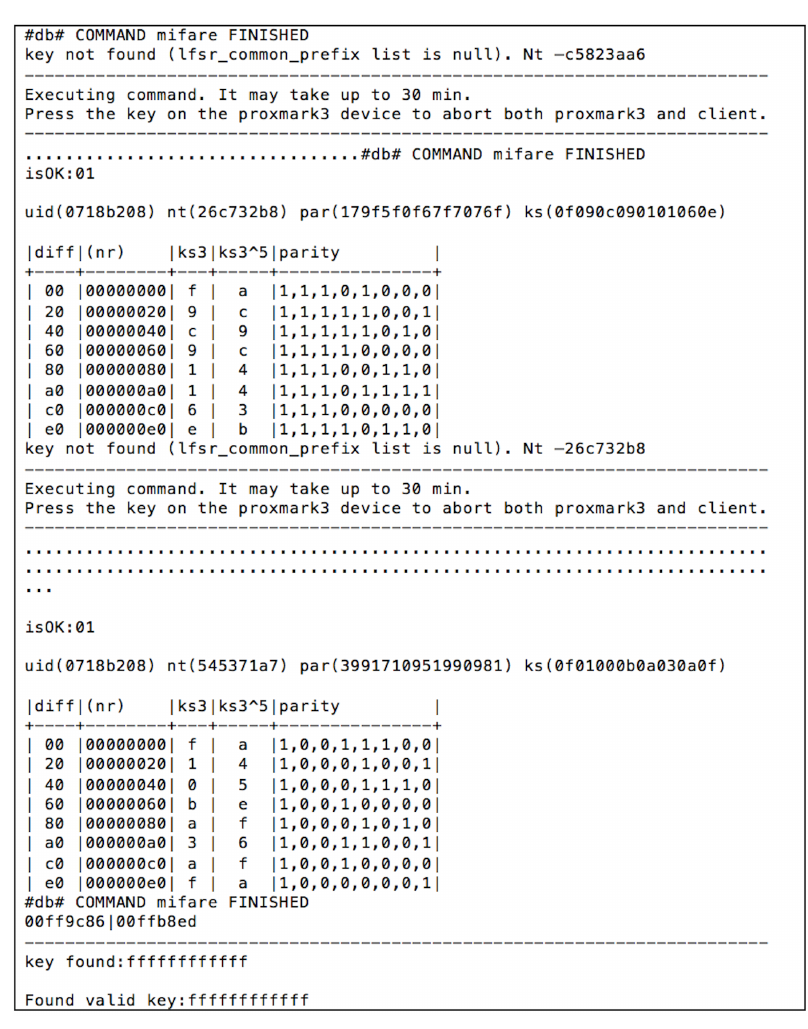
Figure 19. Obtaining the first access key in a MIFARE Classic university card.